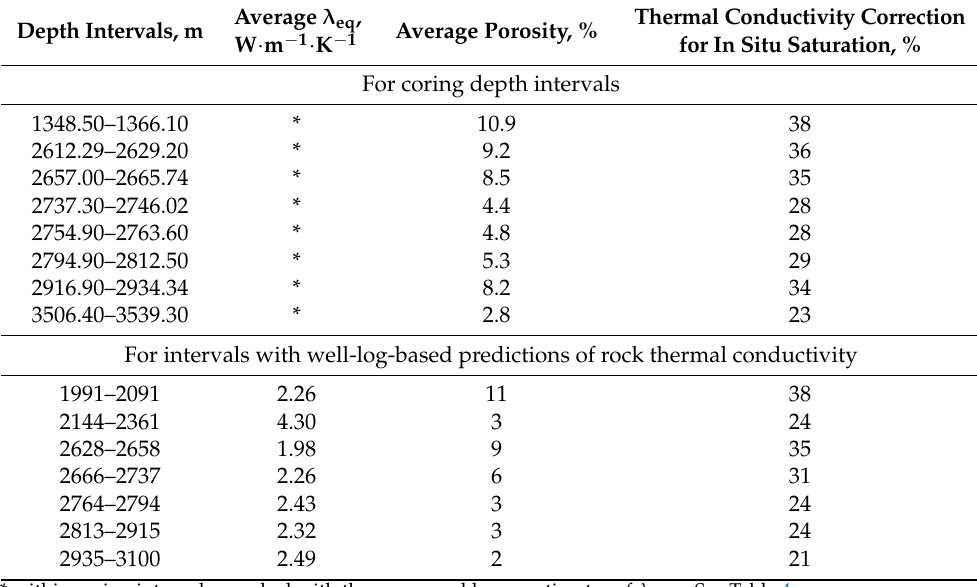
Table 6. Thermal conductivity corrections to account for in situ